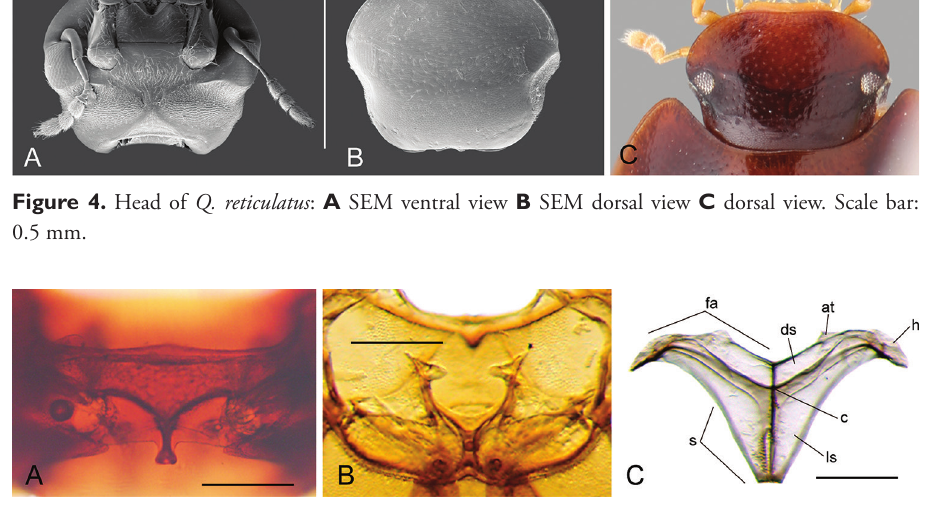
Figure 5. Thorax of Q. reticulatus : A prosternum ventral view B mesofurca dorsal view C metafurca posterior view: (at) anterior tendon, (c) crux, (ds) dorsal sheath, (fa) furcal arm, (h) hemiductus, (ls) lateral sheath, (s) stalk. Scale bar 0.2